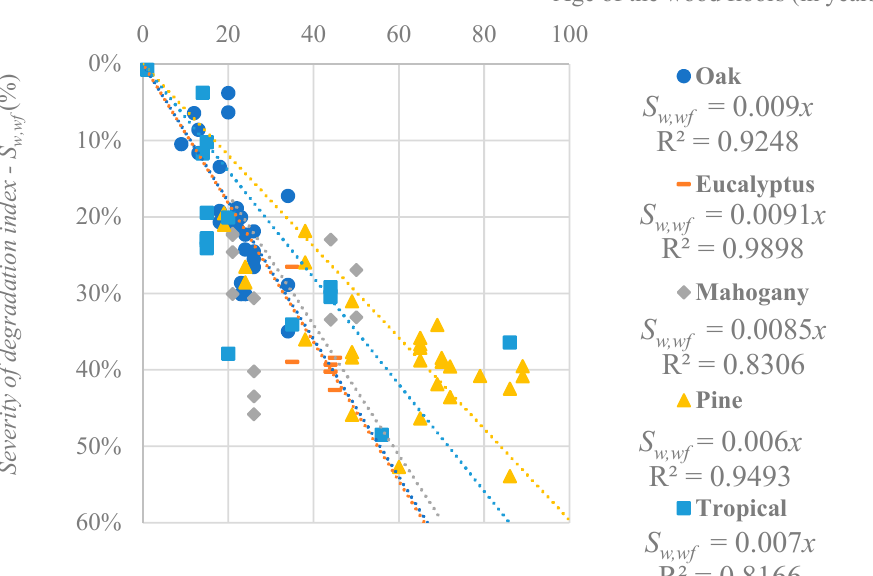
Figure 4. Regression analysis between the numerical index that expresses the degradation of the 96 wood flooring systems ( S w,wf ) and their age, according to the type of wood.